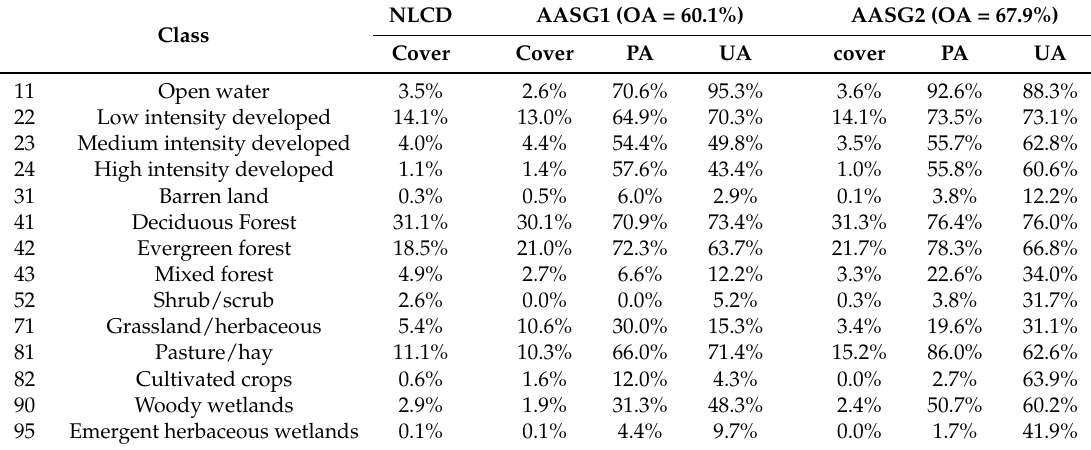
Table 3. Comparison of proportional land cover, overall agreement (OA), producer’s agreement (PA), and user’s agreement (UA) in 2011. Full confusion matrices are presented in Tables